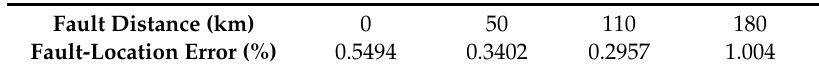
Table 3. Fault-location errors for PG faults at various locations with a fault resistance of 500 Ω , considering the influence of noise.